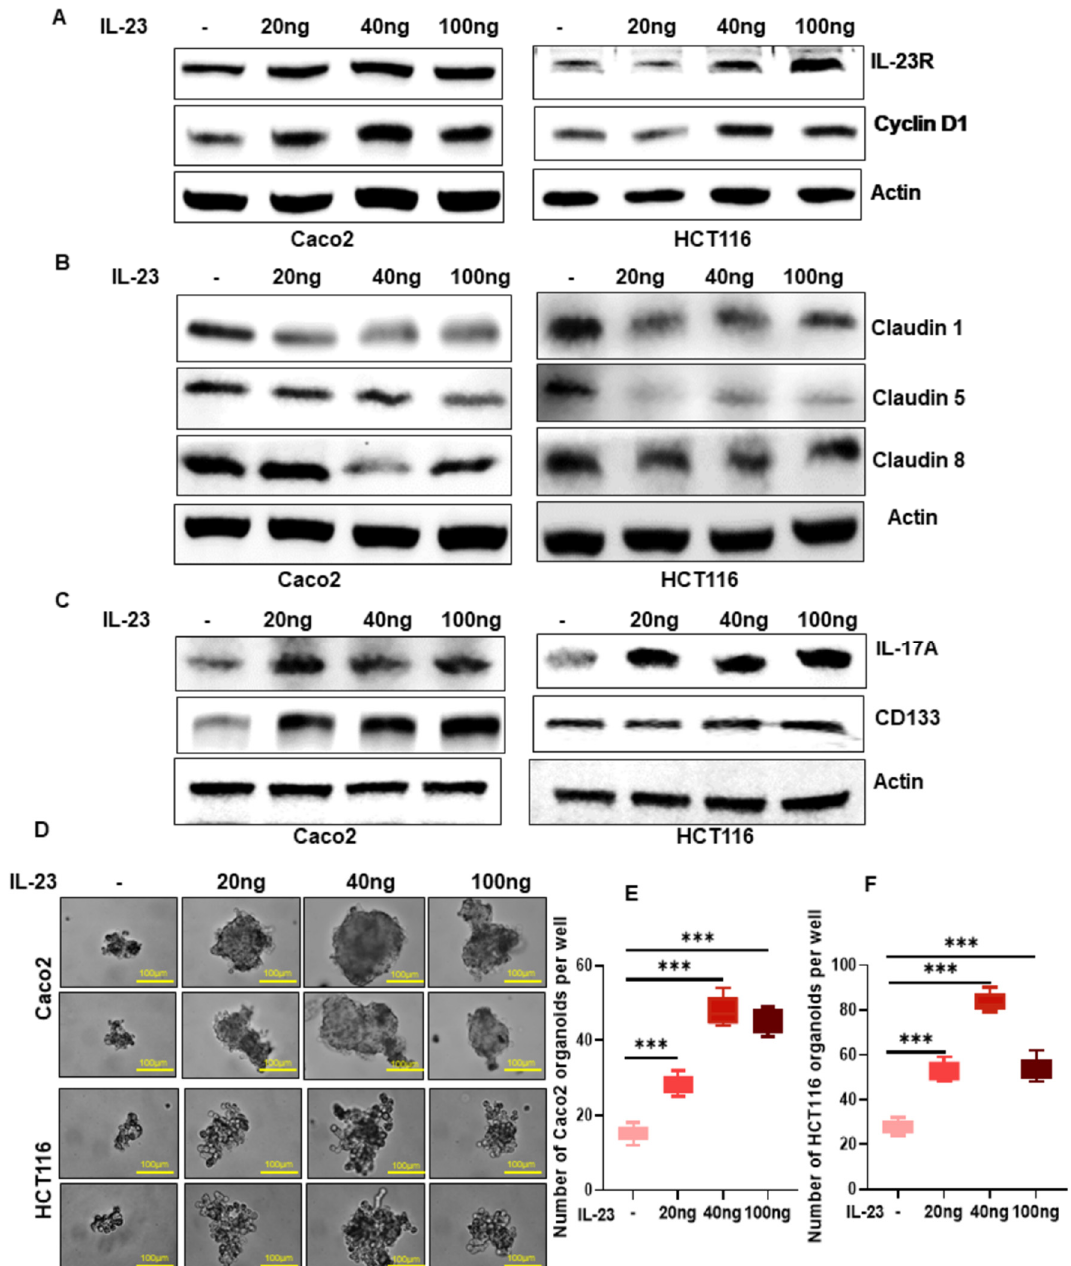
Figure 2. Effect of IL-23 on colon tumor cell proliferation, epithelial barrier integrity, and stemness. ( A ) Western blotting analysis showed that treatment of rhIL-23 in colon tumor cells increased the expression of IL-23R and cyclin D1. ( B ) Western blotting analysis showed the effect of rhIL-23 treatment on the expression of claudin1, 5, and 8 in colon tumor cells. ( C ) Expression of IL-17A and CD133 in colon tumor cells upon treatment with rhIL-23. Beta-actin was used as a protein loading control. ( D ) Treatment of rhIL-23 increased the number of organoids compared with untreated control cells (Magnification 40×). ( E , F ) Quantification of organoids in control and rhIL-23 treated cells. All experiments were performed a minimum of three times. Bars denote standard deviation (SD). * p < 0.05, ** p < 0.01,*** p < 0.001 were considered statistically significant.